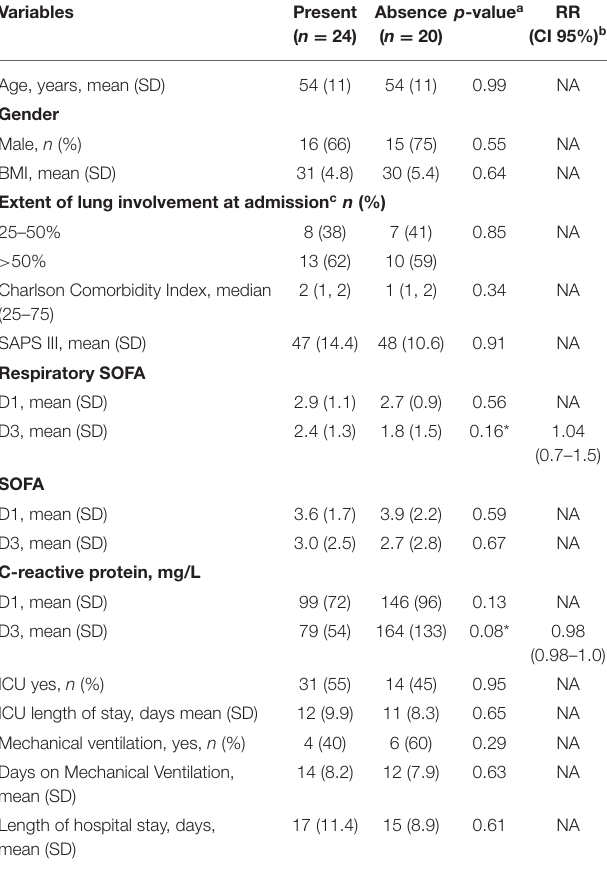
TABLE 3 | Variables associated with desaturation in the six-minute walk test (6MWT) 6-months after hospital discharge.